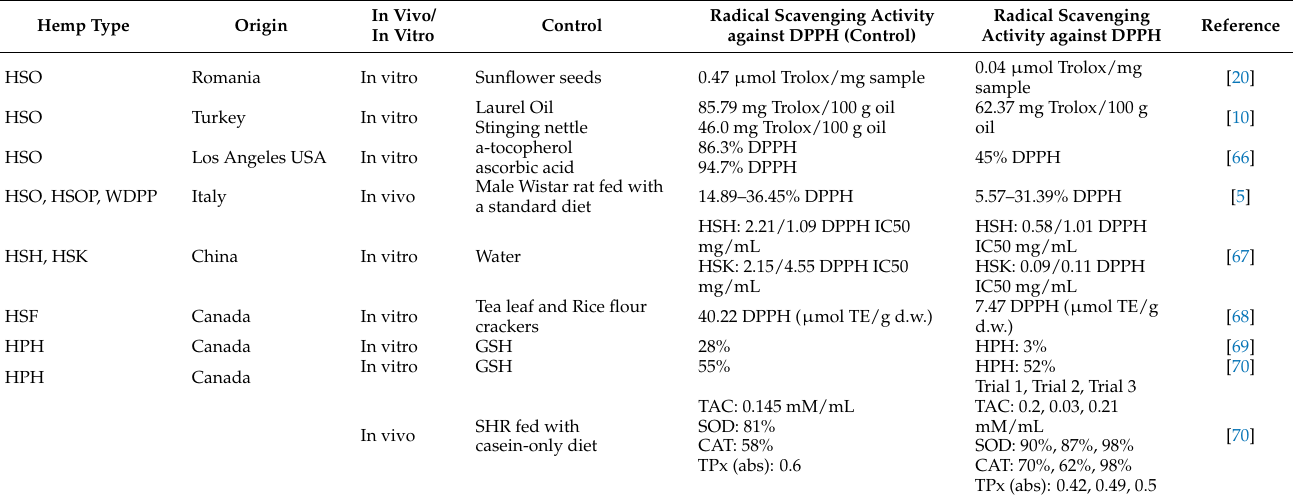
Table 6. Antioxidant activity against of HSO and hemp